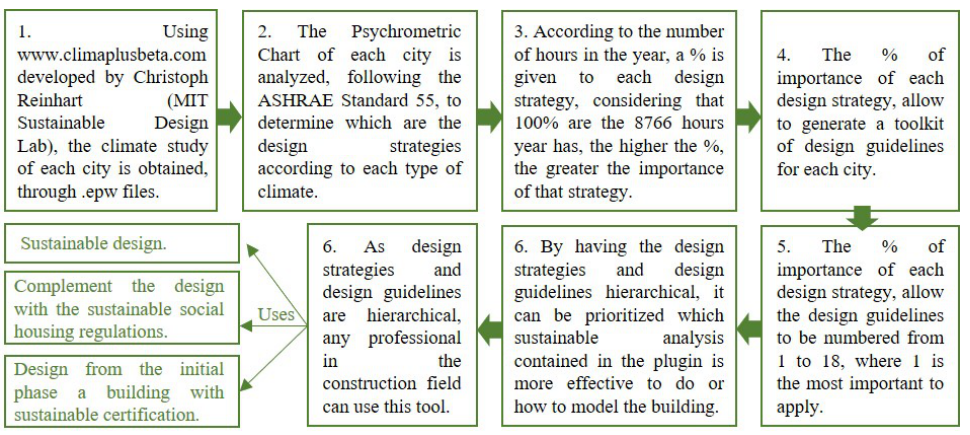
Figure 1. Methodology “Creation of a more effective sustainable plugin for Latin